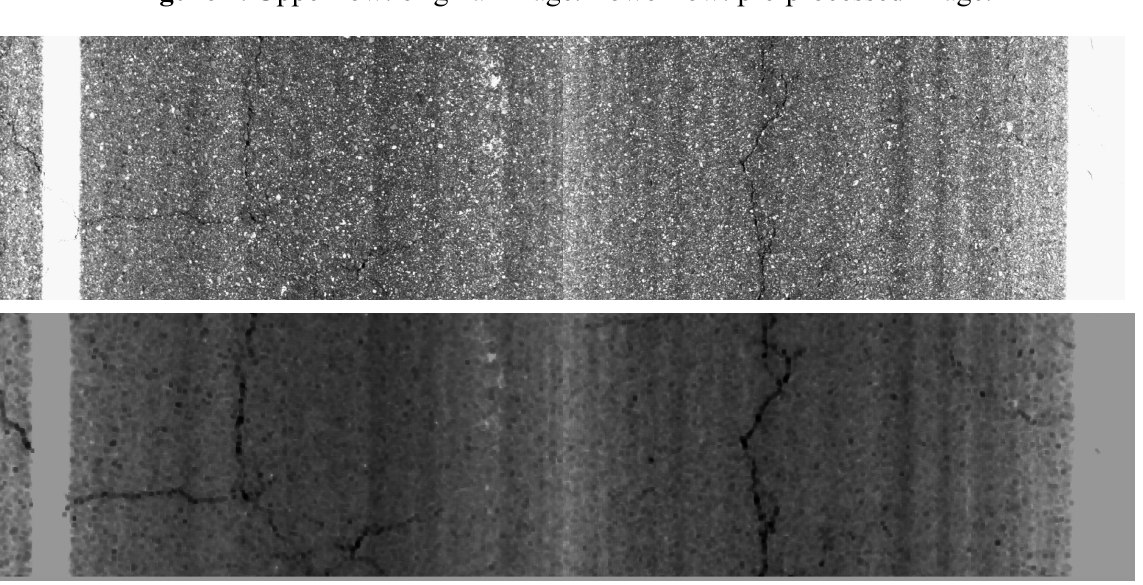
Figure 4. Upper row: original image. Lower row: pre-processed